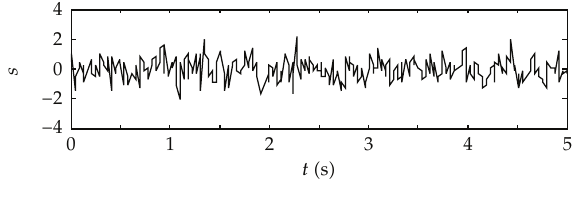
Figure 5: Complex nonperiodic code.